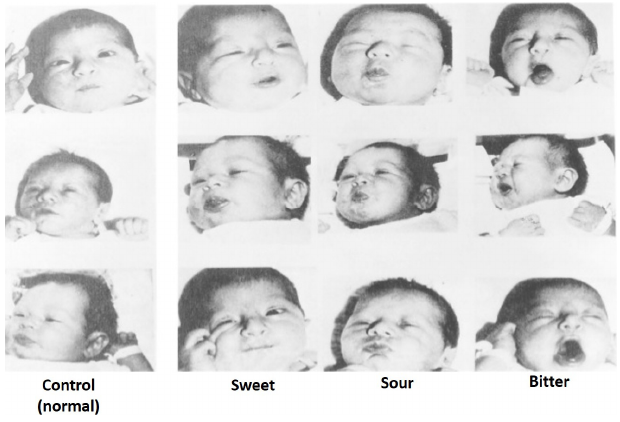
Figure 4. Taste responses to sweet, sour and bitter taste in newborns. Adapted from [54].